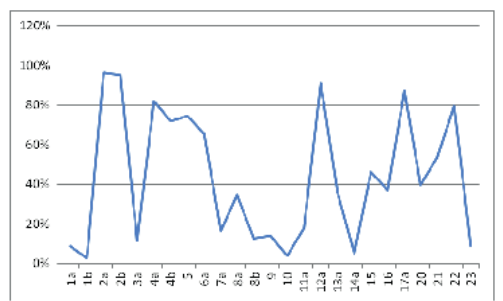
Figure 3 - Frequency of CONSORT items (n = 78). The optional utems were